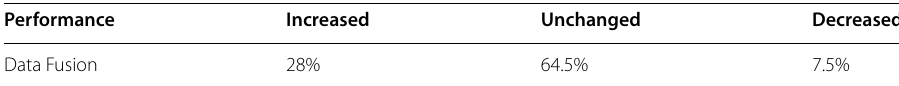
Table 6 Performance changes after data